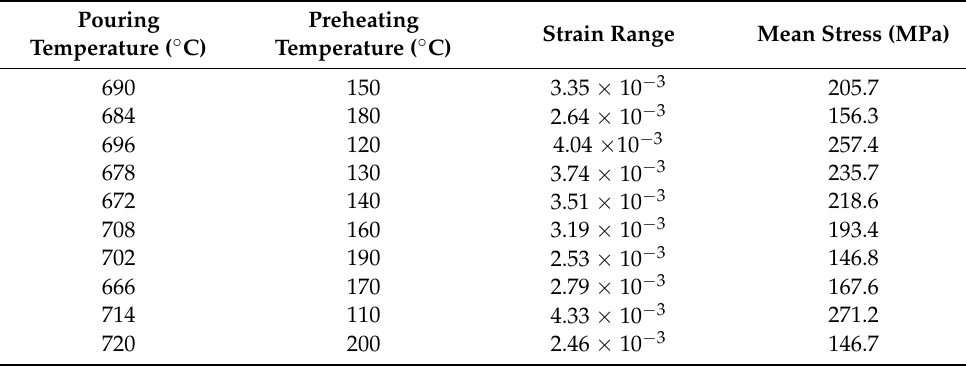
Table 2. Sample points and corresponding response values of training set.